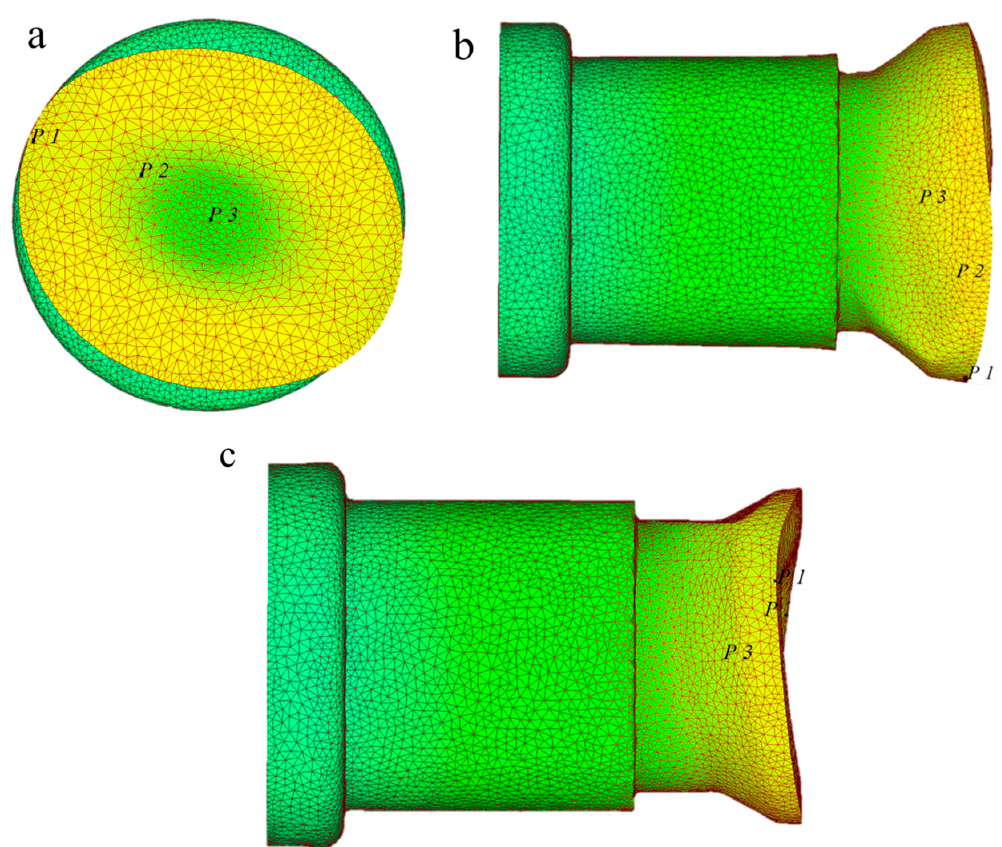
Figure 8. Three views of the rolled piece when rolling time is 2.23 s: ( a ) Z axis direction view of rolled piece; ( b ) Y axis direction view of rolled piece; ( c ) X axis direction view of rolled piece.